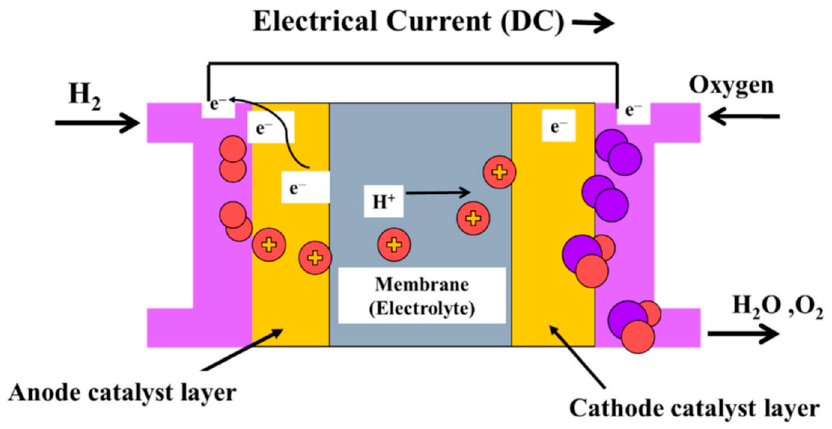
Figure 8. Schematic illustration of fuel cell operation principle. Reprinted from [117].